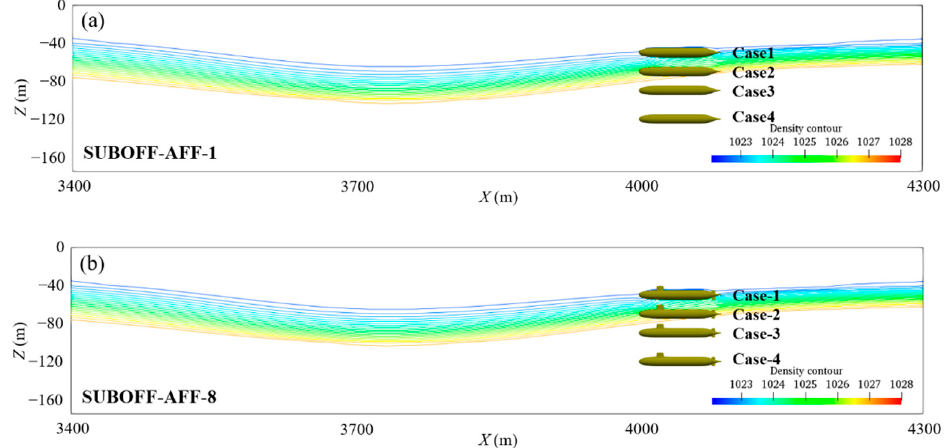
Figure 10. Schematic diagram of numerical simulation conditions of the bare hull ( a ) and fully appended hull ( b ).